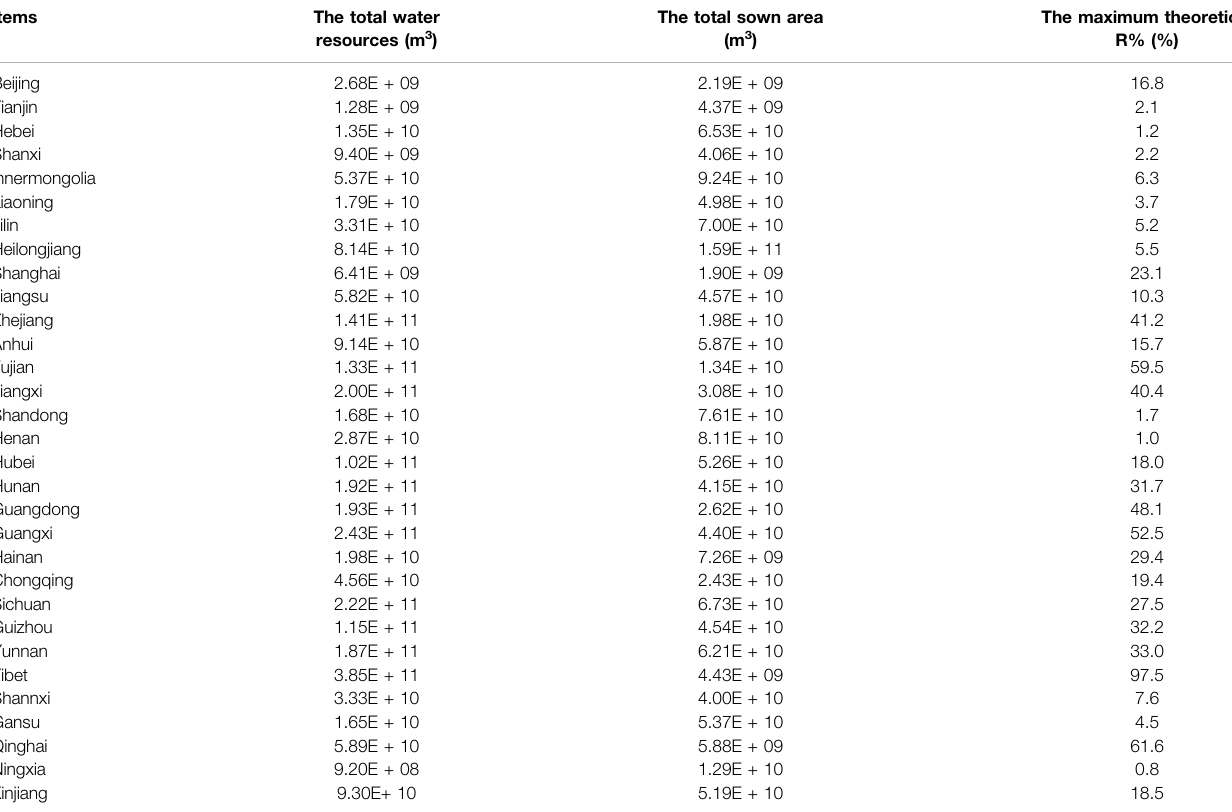
TABLE 6 | The natural resources and maximum proportion of theoretical renewable resources. Items The total water